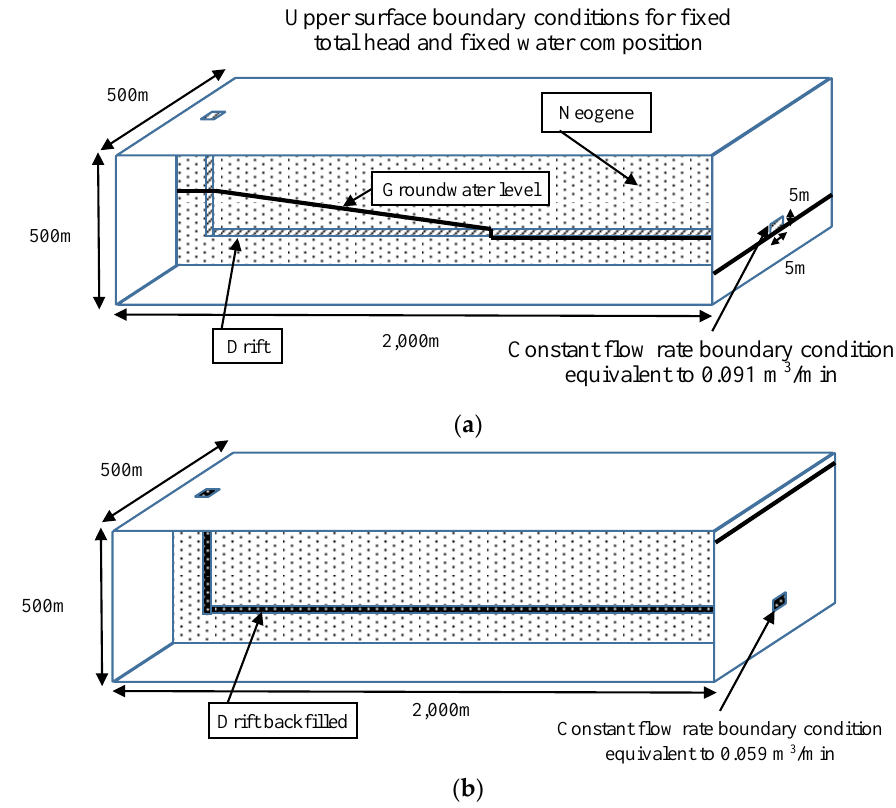
Figure 3. Geochemical reaction model (The cross-sections of the center of the 3D models are shown.): ( a ) before backfilling and ( b ) after backfilling. Table 2. Boundary conditions of the groundwater flow and geochemical